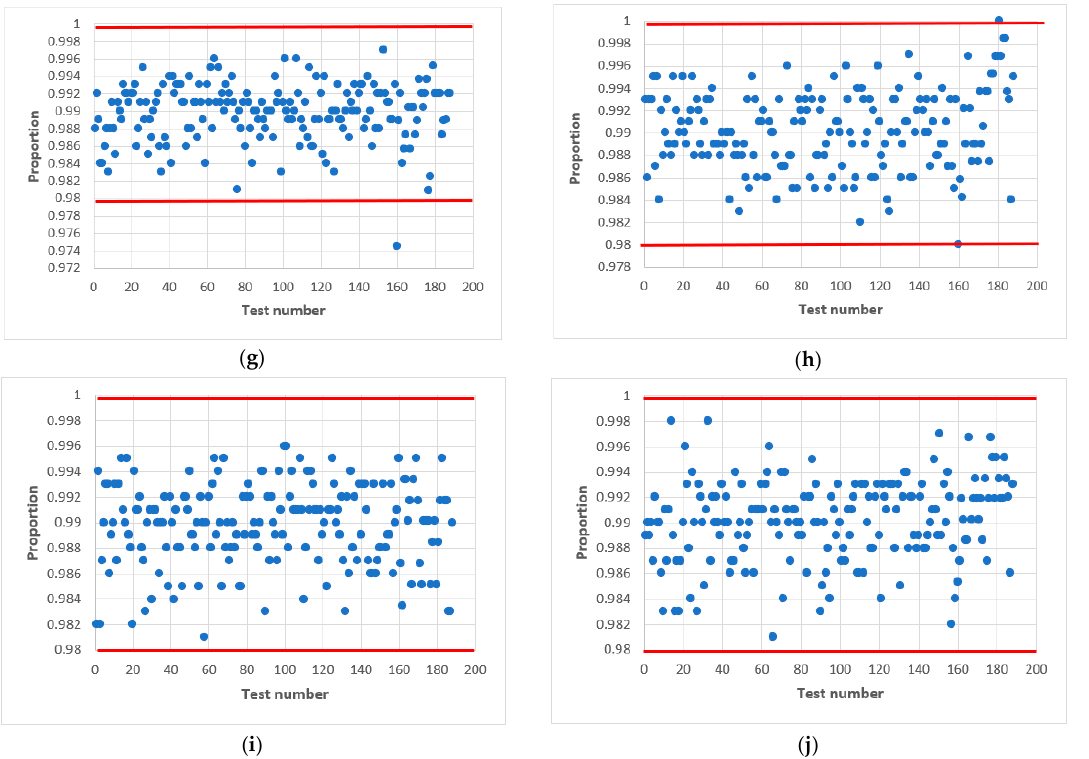
Figure 11. Statistical portrait of the combined generator for h = 9, a = a 0 ⊕ a 3 with initial